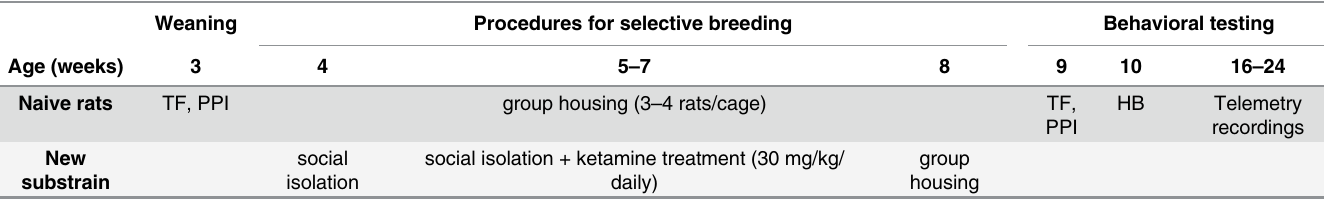
Table 1. Schedule of the experimental protocol for selective breeding and behavioral testing.